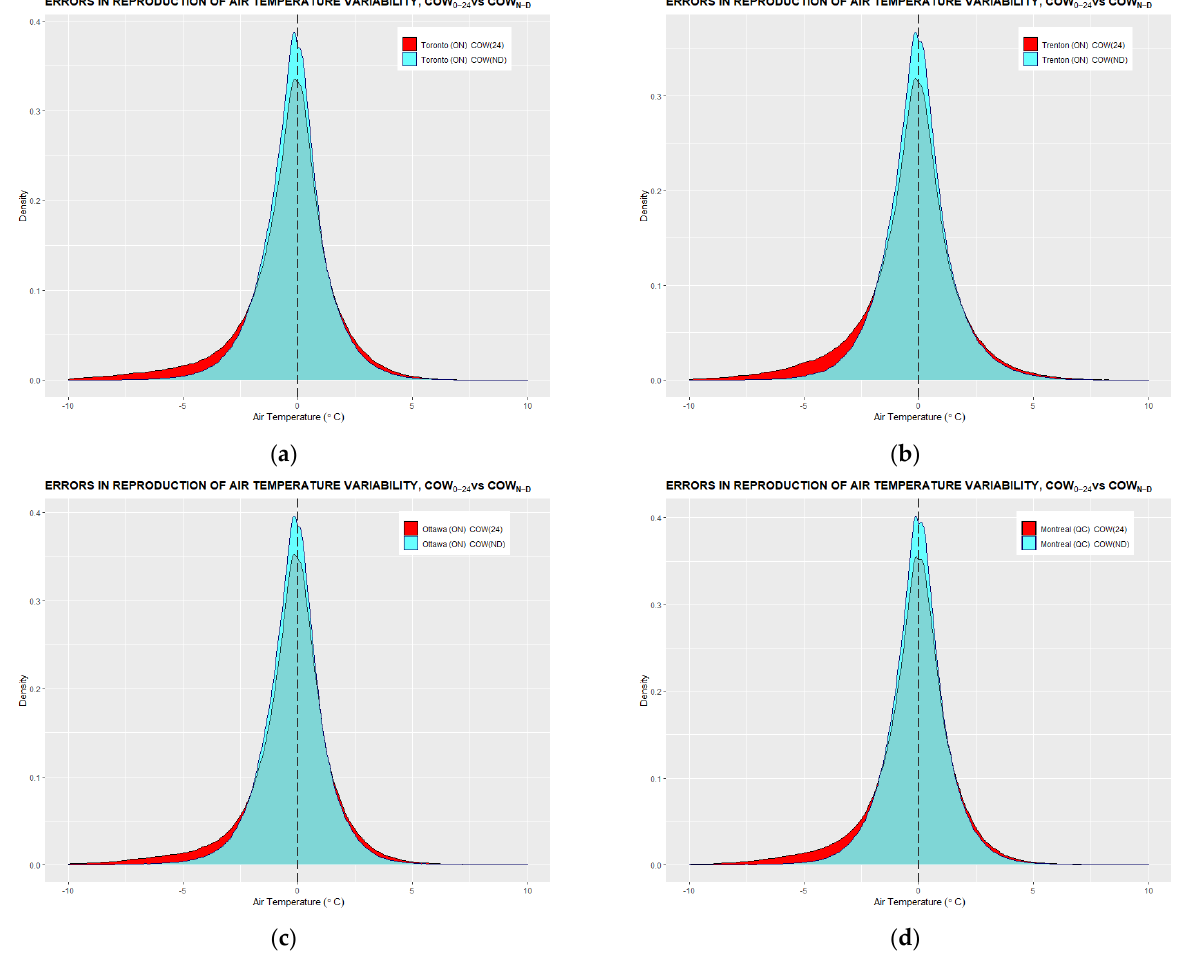
Figure 6. Histograms of conformity of COW 0–24 and COW N–D reproduced temperature with ob- served 66 year-long hourly temperature data from the Great Lakes/St. Lawrence Lowlands climate region at Toronto ( a ), Trenton ( b ), Ottawa ( c ), and Montreal ( d ) stations.